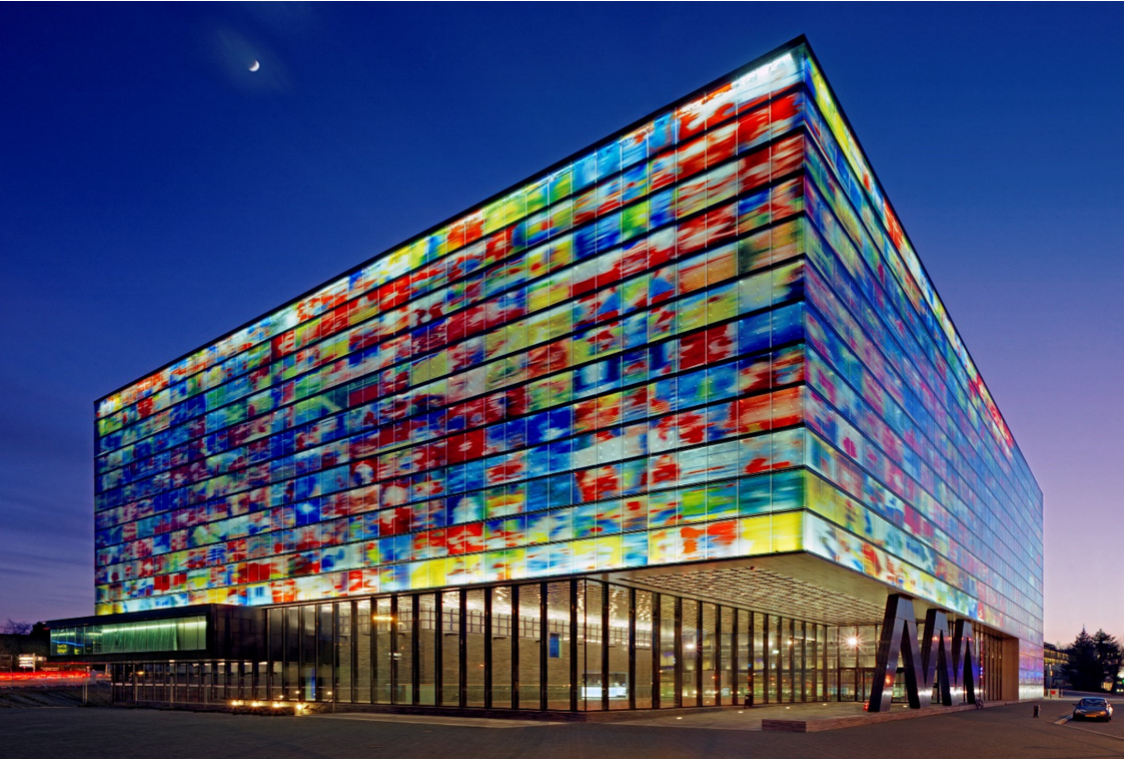
Fig. 1 ‘Beeld en Geluid’, Hilversum, the Netherlands. Photography scagliolabrakkee © Neutelings Riedijk